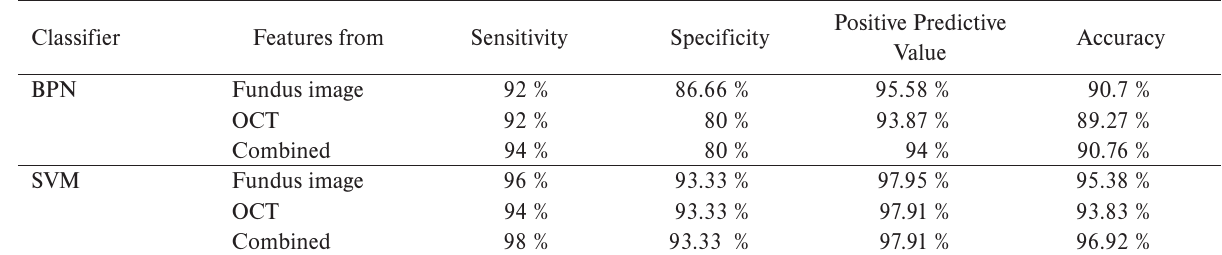
Table 6. Analysis of